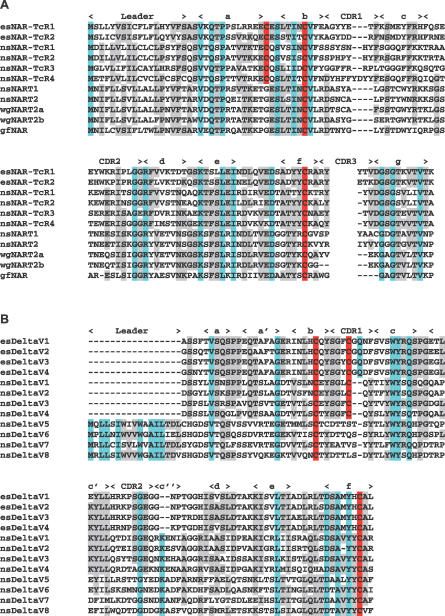
NAR-TcR Genes in the Elephant Shark(A) Alignment of predicted amino acid sequences of some representative elephant shark NAR-TcRV (esNAR-TcR1 and esNAR-TcR2) with their homologs from the nurse shark (nsNAR-TcR1 to nsNAR-TcR4) and IgNARV sequences from nurse shark (nsNART1 and nsNART2), wobbeygong shark (wgNART2a and wgNART2b) and guitarfish (gfNAR). Alignment of CDR3s, which are highly variable in sequence and length, is not shown.(B) Alignment of predicted amino acid sequences of putative elephant shark NAR-TcRV–associated TcRδV (esDeltaV1 to esDeltaV4) with nurse shark NAR-TcRV–associated TcRδV sequences (nsDeltaV1 to nsDeltaV4), and typical nurse shark TcRδV sequences (nsDeltaV5 to nsDeltaV8). Leader regions, β-strands, and complementarity-determining regions (CDRs) are indicated above each alignment. Conserved residues are highlighted in blue and gray, and conserved cysteine residues in immunoglobulin superfamily canonical intradomain and putative interdomain disulfide bridges are highlighted in red. Note the conserved cysteine residue in the a-b loop and the absence of the canonical tryptophan of the “WYRK” motif in the NAR-TcRV sequences (alignment A). The NAR-TcRV–associated TcRδV lacks the leader peptide, and encodes a conserved cysteine residue in the CDR1 (alignment B). Sequences of nurse shark, wobbeygong shark, and guitarfish are taken from Criscitiello et al. [43].